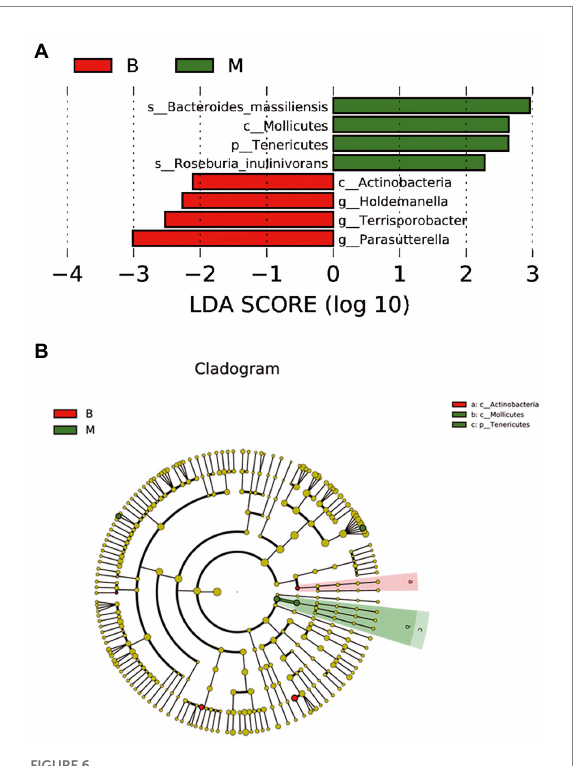
FIGURE 6 LDA effect size analysis between Group M and Group B. (A) Microbial species with a significant difference in abundance and a significant effect between the two groups. (B) A clustering tree. The concentric circles from the inside to the outside represent the classification levels of phylum, class, order, family, and genus (or species). The green and red nodes indicate microbial species that played an important role in groups M and B. The diameter of the node circle is proportional to the relative abundance of the taxonomic microbiota, which reflects a significant difference in microbial strains between the two groups and their biological